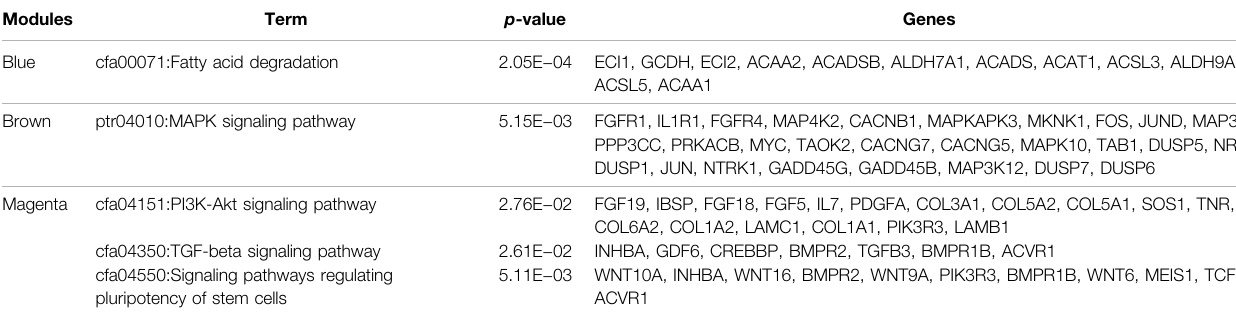
TABLE 3 | KEGG analysis of candidate modules (adjusted p -value ≤